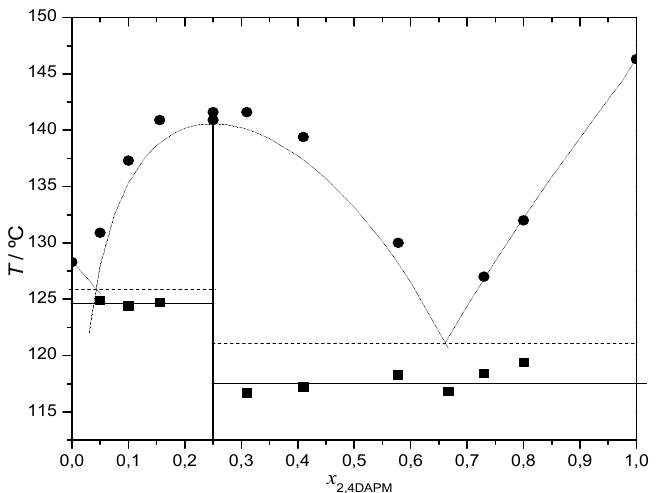
Figure 2. (Solid + liquid) binary phase diagram of DAP + NA; ■ and solid line—experimental solidus; ●—experimental liquidus . Dotted lines obtained using eqs. ( 1 ) and ( 2 ).